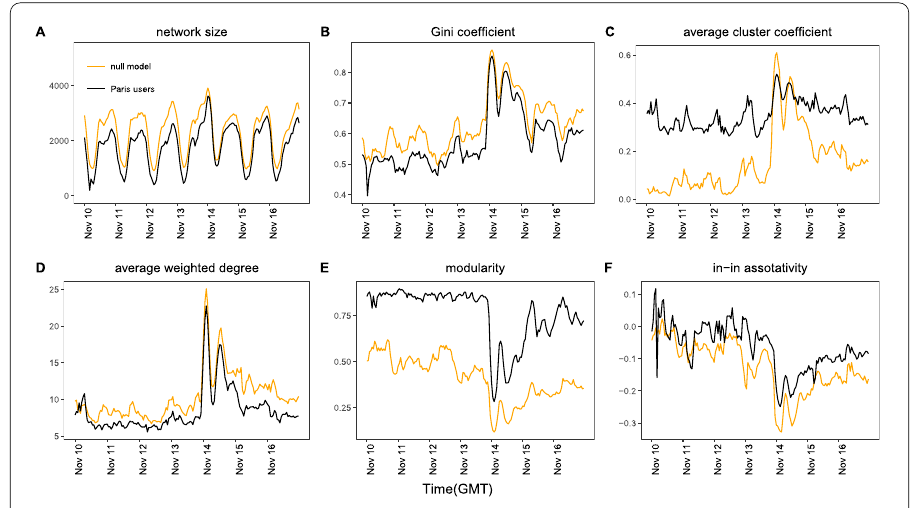
Figure 4 Comparison with a null model. The comparison of the collective attention measured by the original attention graph and the null model during the event week with the event day (Nov. 13, 2015) centered in the